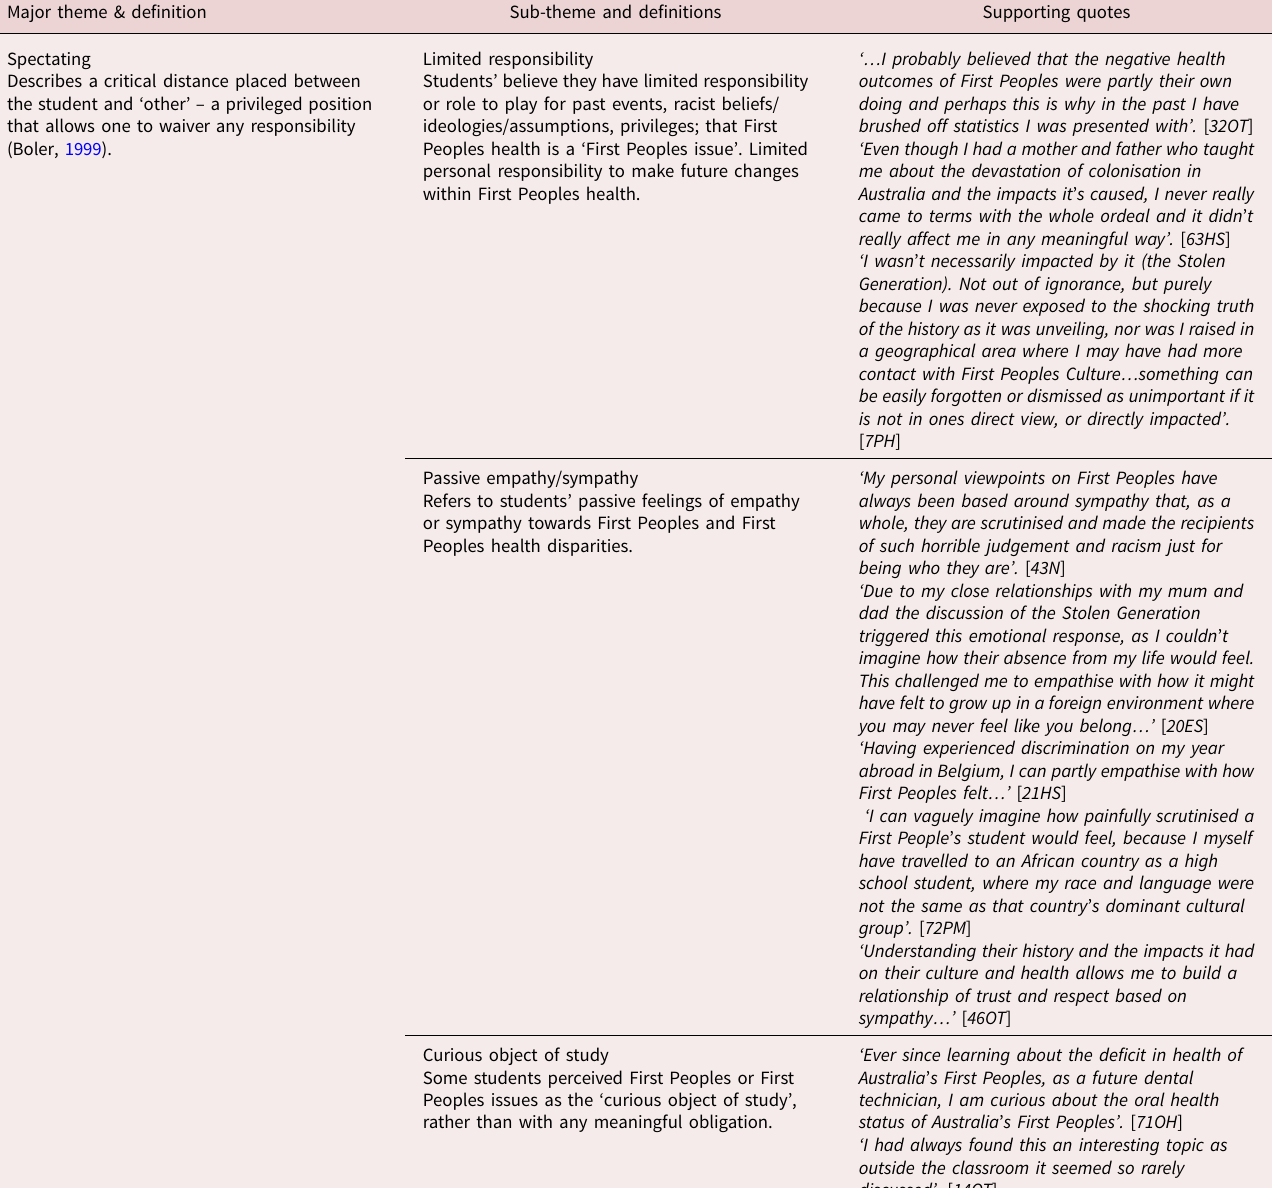
Table 2. Major category of ‘ Spectating ’ with subcategories, definitions and a selection of supporting